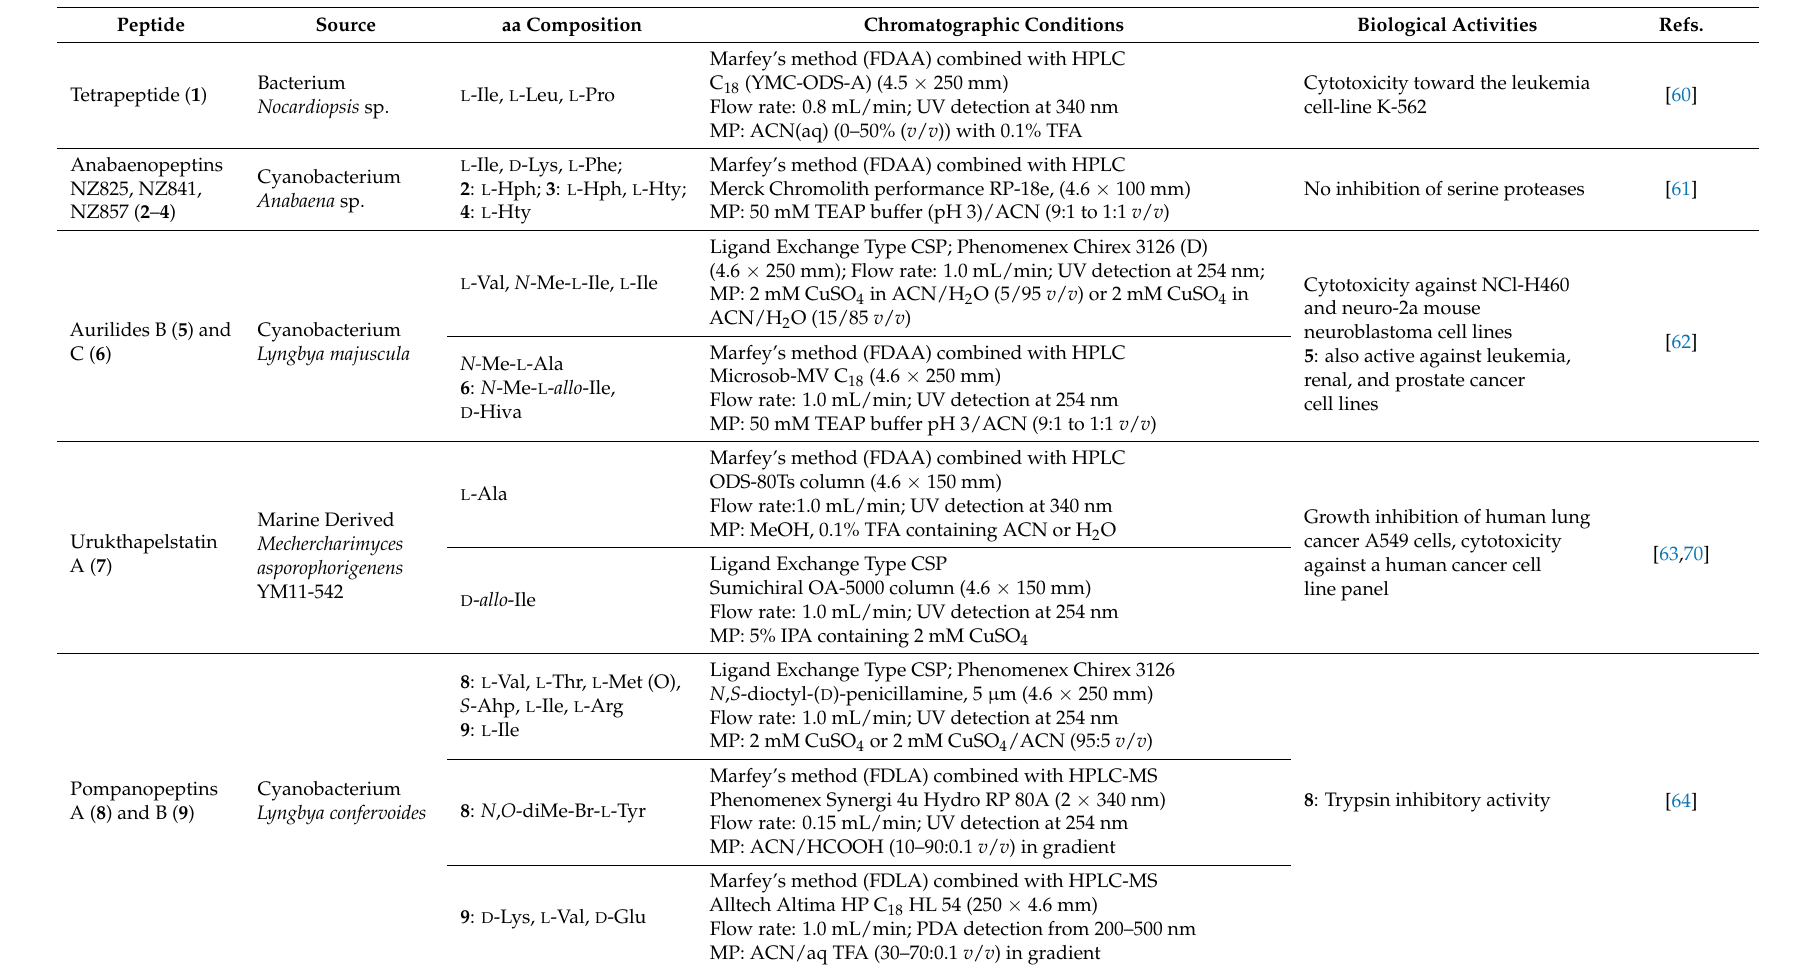
Table 1. Cyclic peptides from marine cyanobacteria and other